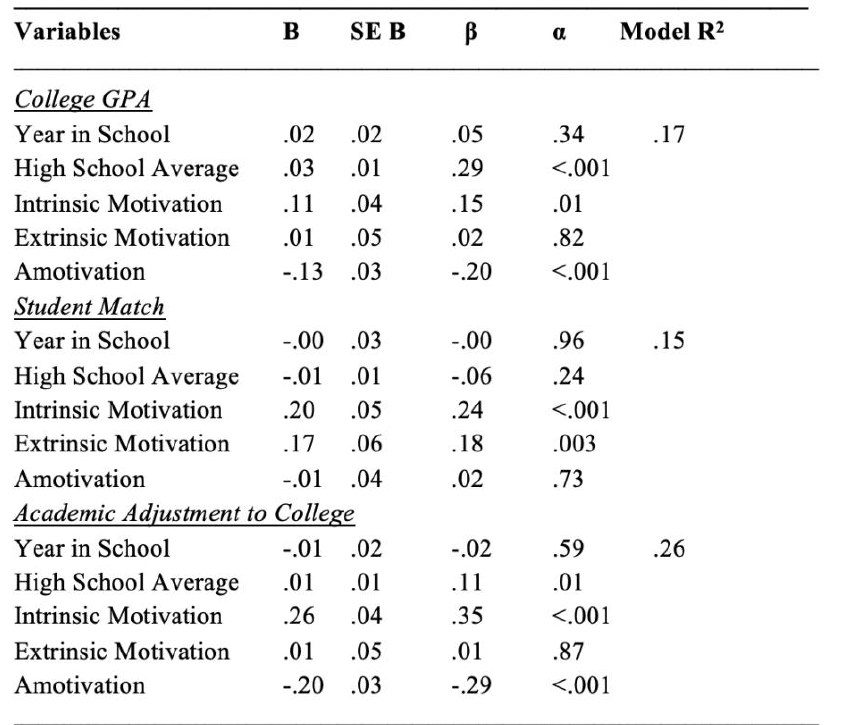
Study 1: Regression analysis predicting college